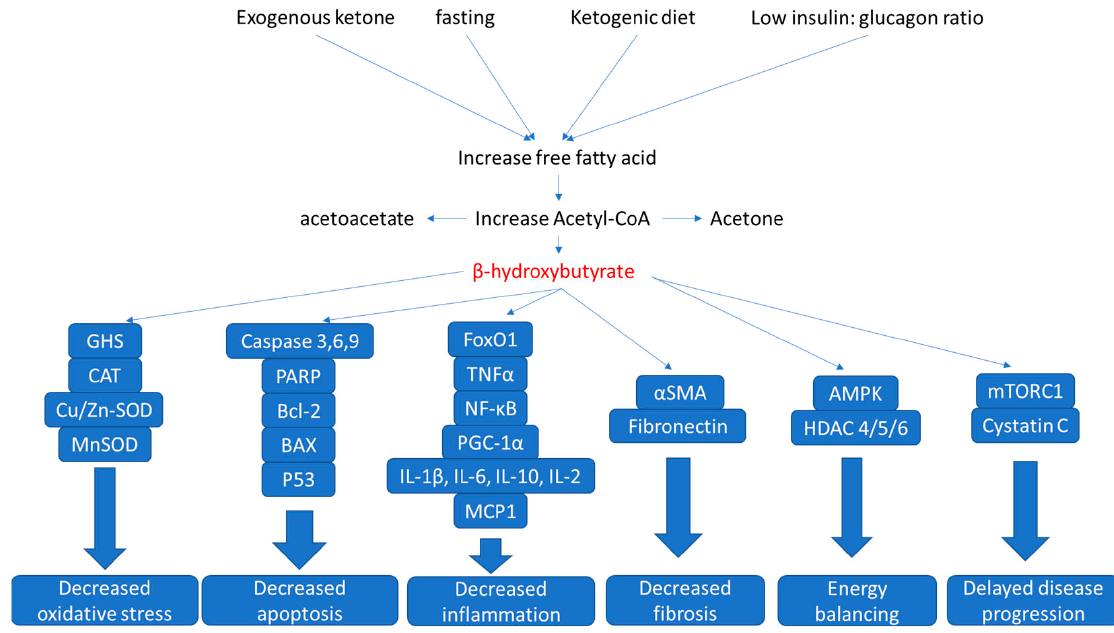
Figure 5. Nephroprotective mechanisms of ketone bodies. Shown are sources of ketone bodies and the potential underlying mechanisms of renal protection by ketone bodies involved in kidney diseases discussed in this text.